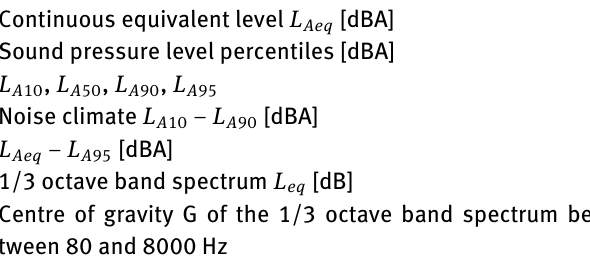
Table 2: Acoustical parameters considered in the